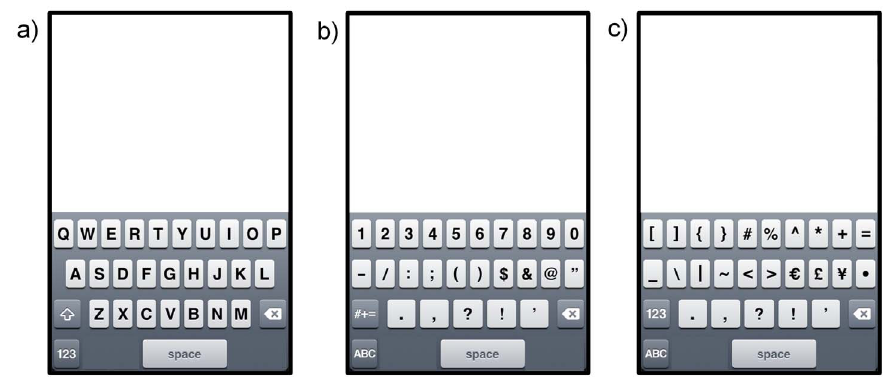
Figure 4. Key layout for Apple iOS 5.1’s touch keyboard for the iPhone 4S (Apple Inc.) used in for the simulated typing task. (a) Letters layout; (b) numbers layout; (c) symbols layout.